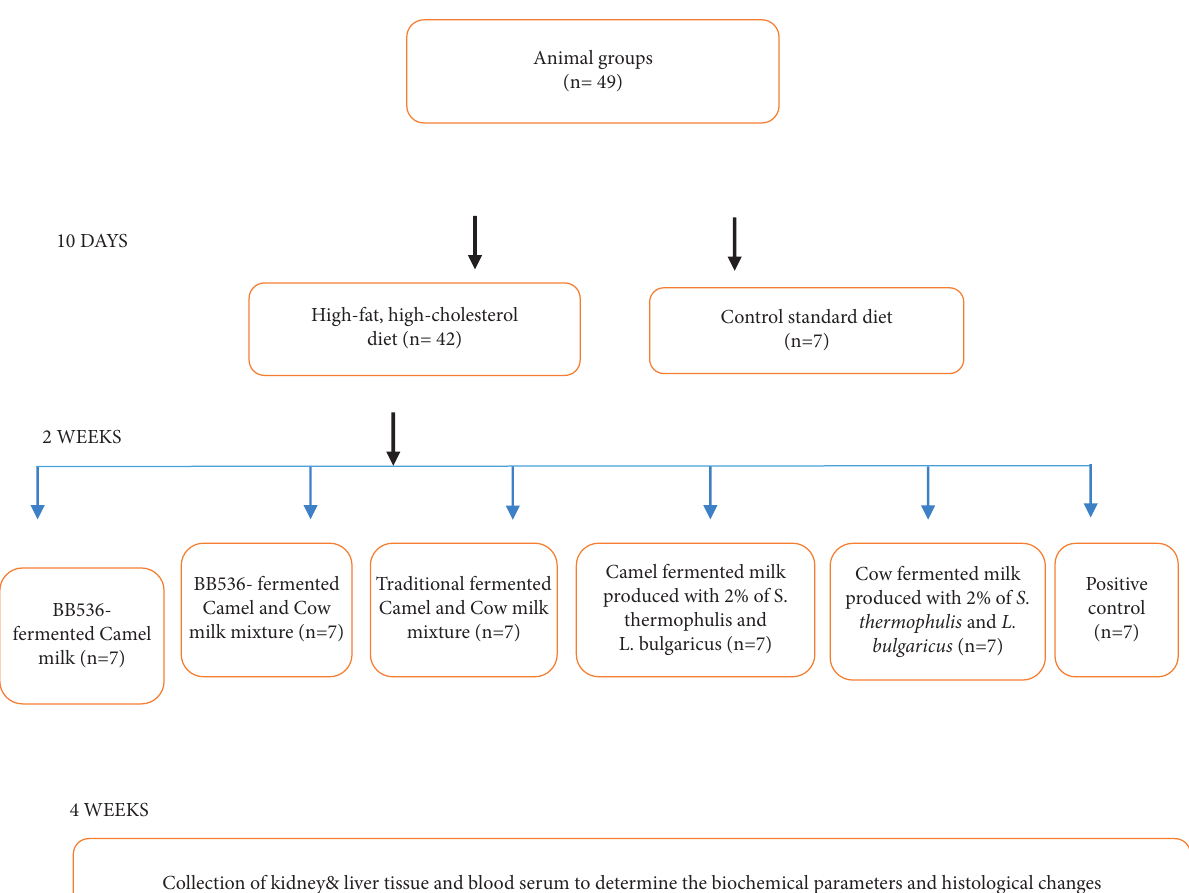
Figure 2: Diagram showing experimental design with animal groups.